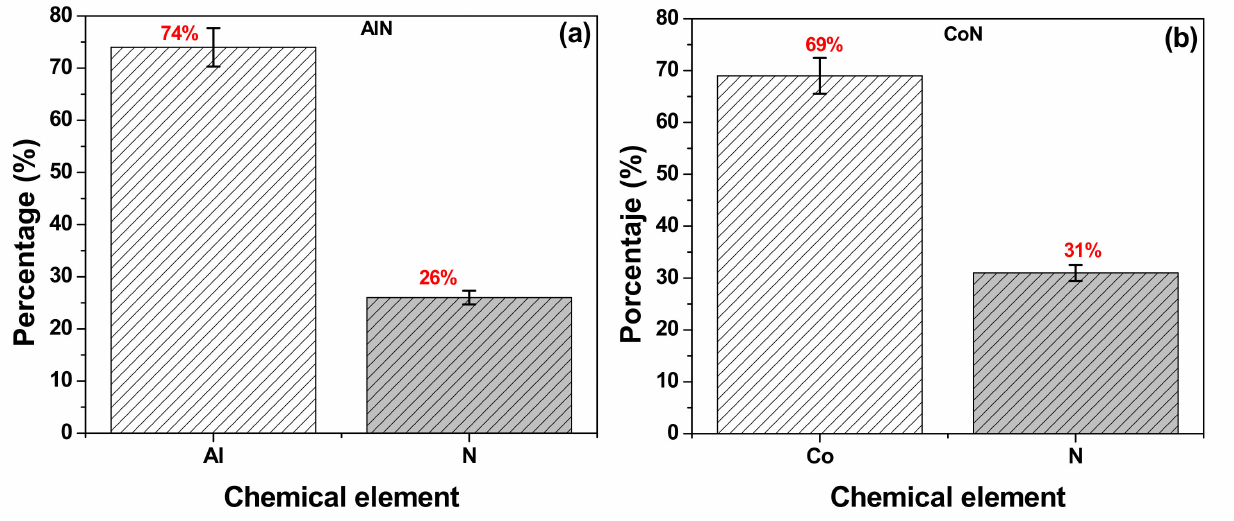
Figure 5. Elemental percentages according to the coating stoichiometry ( a ) aluminum nitride layer (Al 74 N 26 ), ( b ) cobalt nitride layer (Co 69 N 31